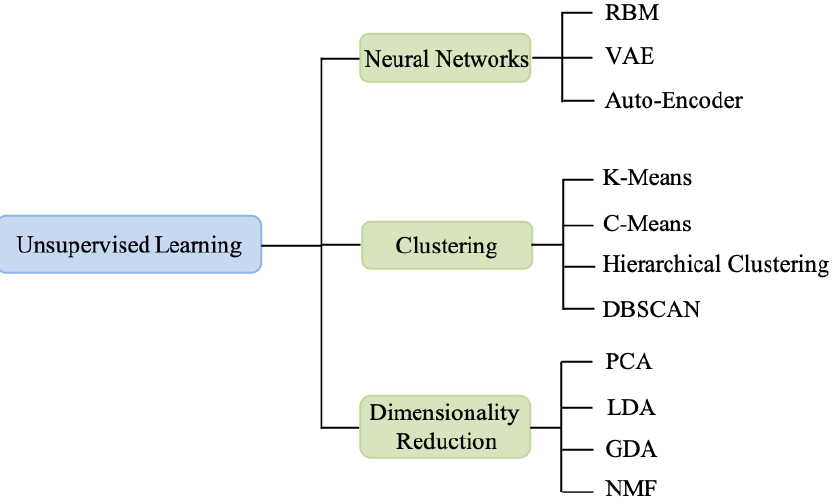
Figure 3. Unsupervised learning techniques